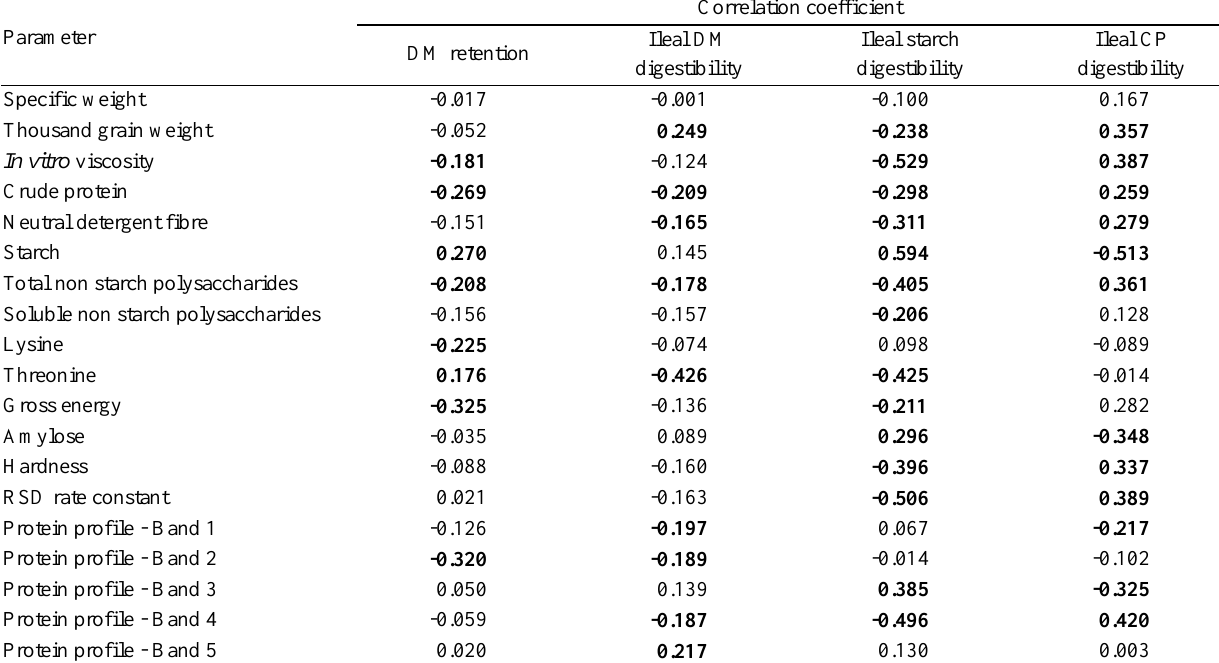
Table 4. b) Relationships between bird digestibility parameters and chemical and physical parameters of